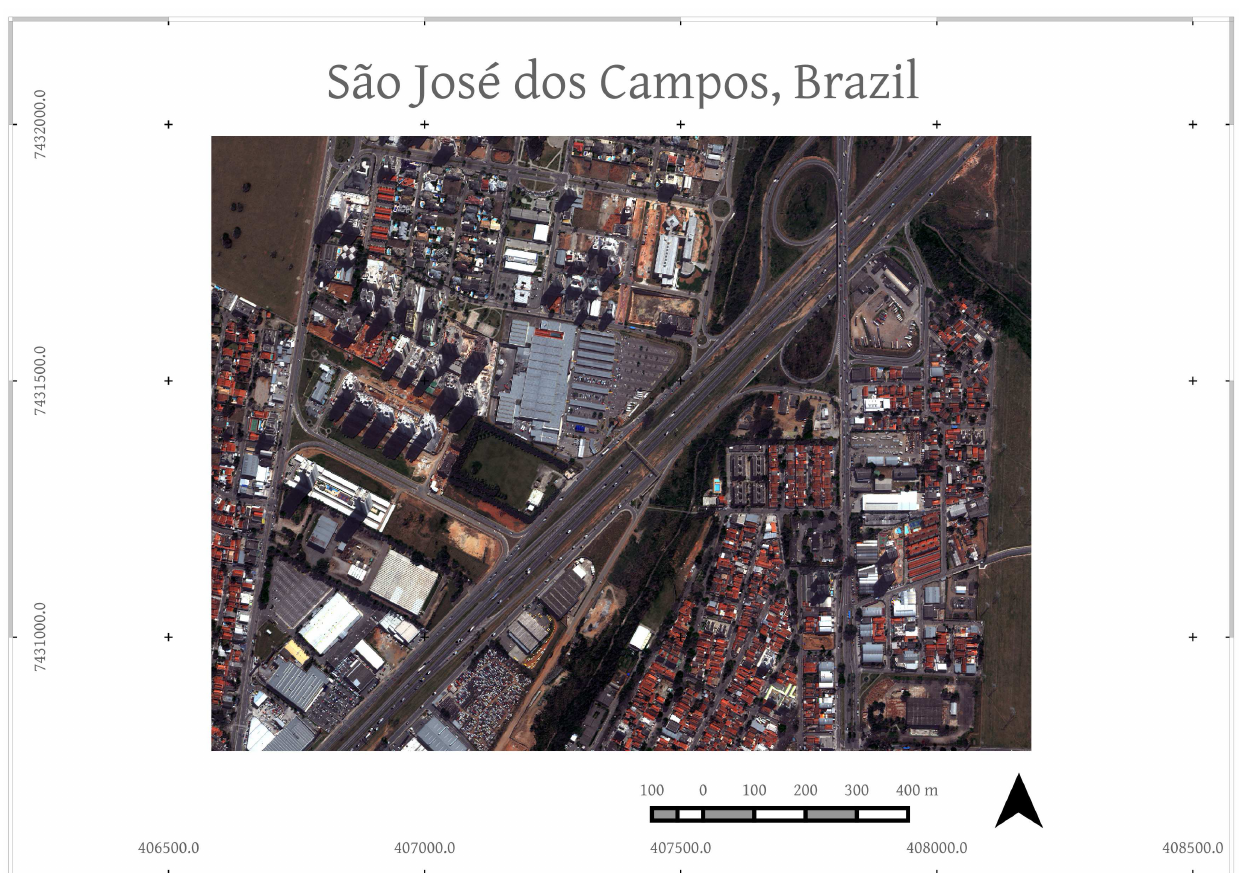
Figure 4. Input image, obtained by World View 2